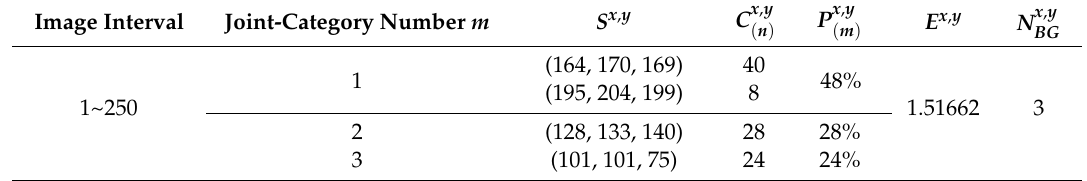
( c ) Figure 4. The color change of a video series at the sampling position (72, 38): ( a ) the first input image, ( b ) the 250th input image, with the red dot on the diagram representing the sampling position, and ( c ) color distribution of the first to 250th input images. Table 1. Color classification results of the first 250 input images at the coordinate (100, 40). Image Interval Joint ‐ Category Number m